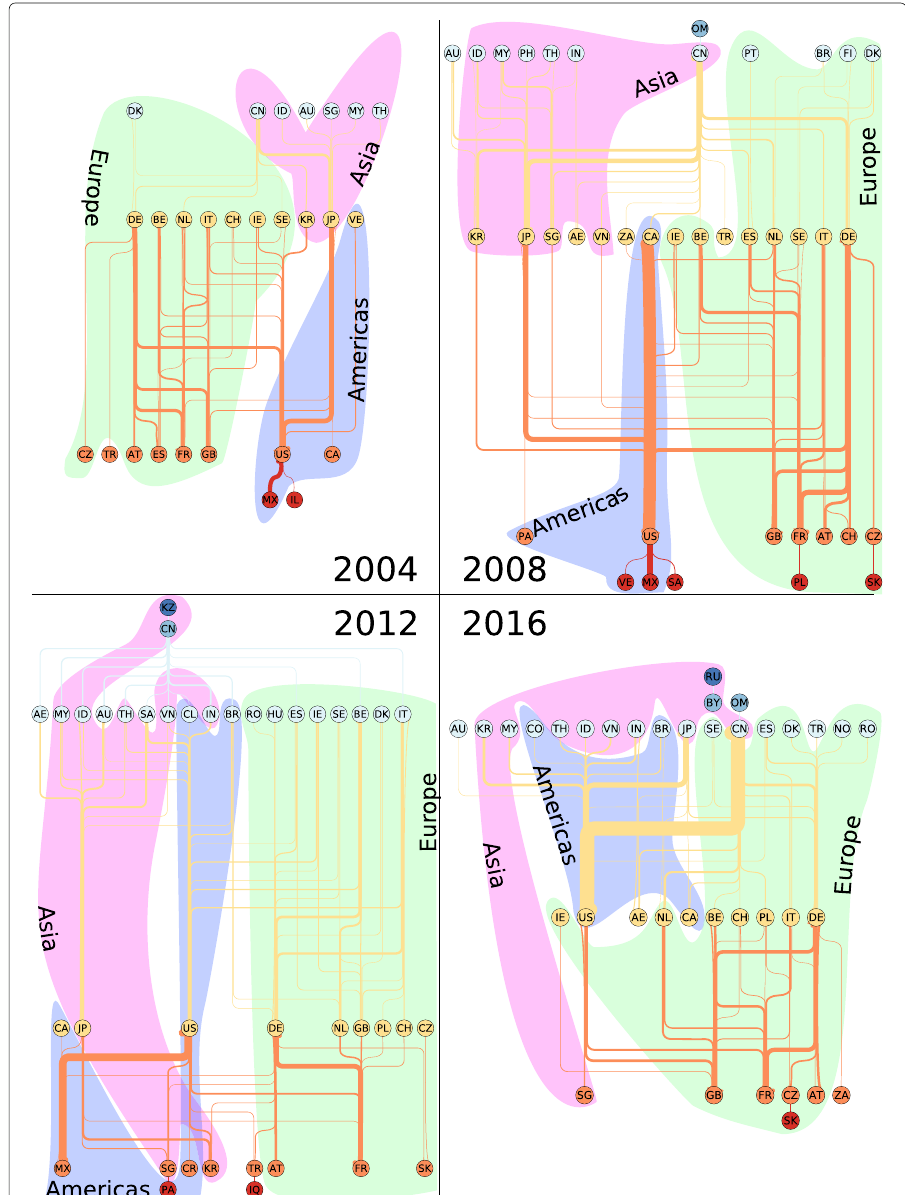
Fig. 9 Crisis contagion network with a hierarchical layout for years 2004, 2008, 2012, and 2016. Only imports greater than 10 10 USD are represented. Countries going to bankruptcy at the same contagion step τ are aligned in the same row. From bottom (red country nodes) to top (blue country nodes), the rows are associated to contagion step from τ = 0 to τ = 3 for 2004, τ = 4 for 2008, τ = 5 for 2012 and 2016. The width of the link going from a country c which goes to bankruptcy at the stage τ to a country c (cid:2) which goes to bankruptcy at the stage τ (cid:2) = τ + 1 is proportional to the volume usually imported by country c from c (cid:2) . Here, once a country goes to bankruptcy, it is prevented to import products with the exception of petroleum and gas (model A). Colored zones gather countries from the same continent (green for European countries, blue for American countries, and pink for Asian countries). The bankruptcy threshold is κ = 0.1 and the damping factor is α =